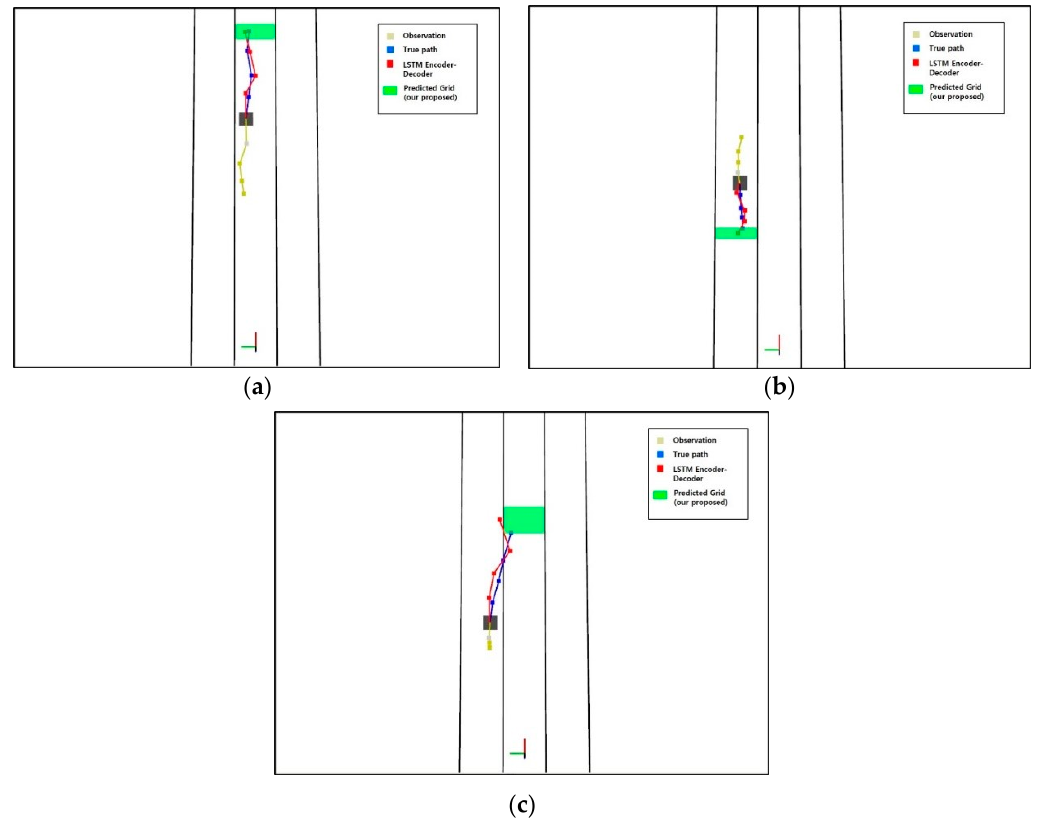
Figure 18. Trajectory prediction results using the proposed grid prediction model: ( a ) acceleration and lane-keeping; ( b )